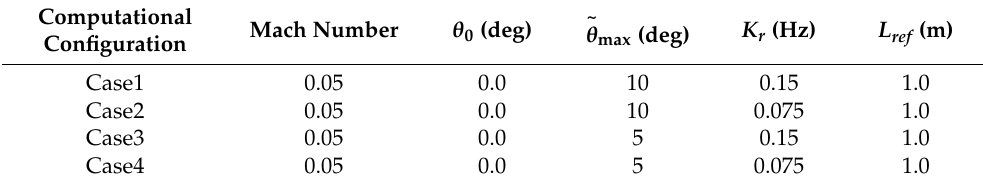
Table 1. The calculation conditions of the motion parameters. Computational